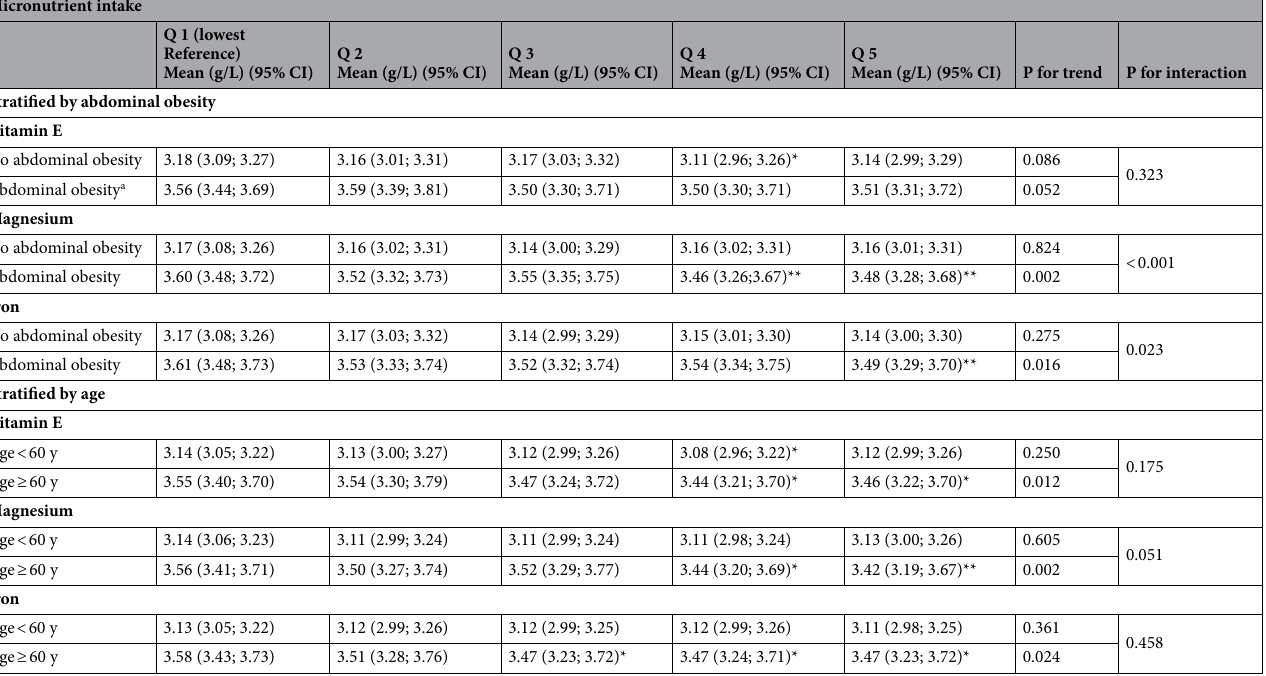
Table 4. Geometric means of plasma concentration of fibrinogen by quintiles of micronutrient intake, stratified by abdominal obesity and age. Linear regression models adjusted as model 2 in Table 2. Please, note that each row depicts a separate model. a Waist circumference > 102 cm in men and > 88 cm in women. *p ≤ 0.05 **p < 0.01 ***p < 0.001. P values for differences in plasma fibrinogen levels across quintiles of micronutrients intake (quintile 1 as reference) using the linear regression